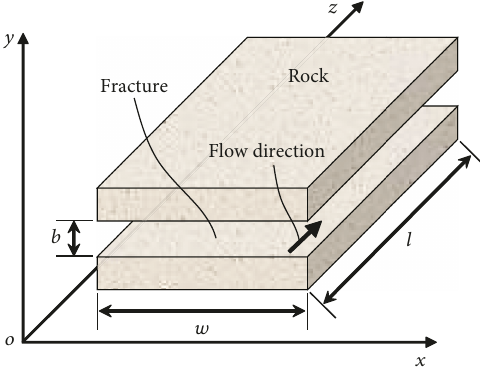
Figure 3: Scheme of fl ow between parallel